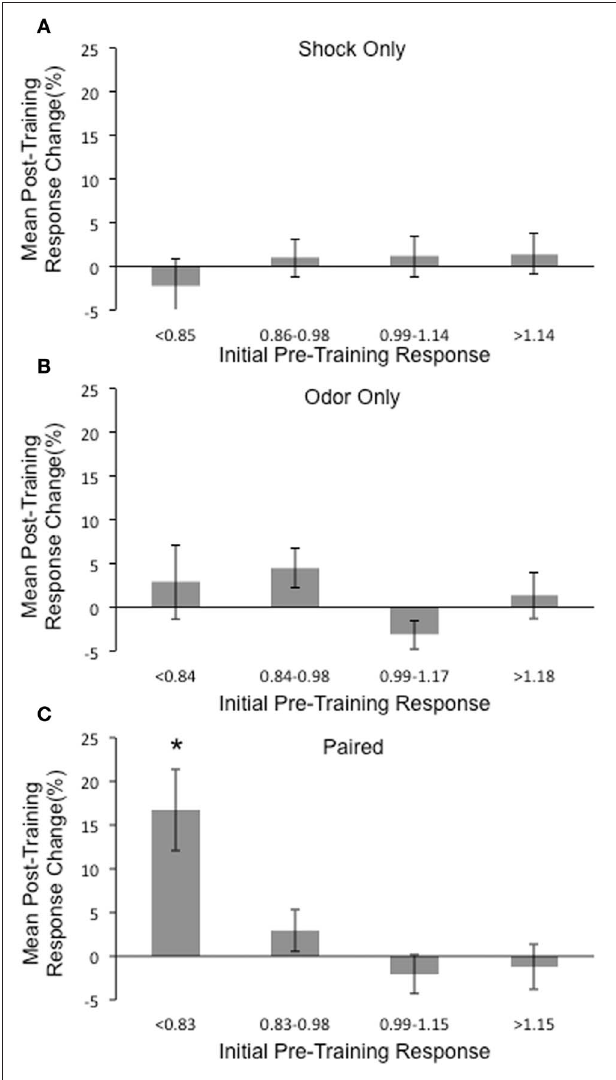
FIGURE 7 | Comparison of the mean post-training response changes in glomeruli based on initial responses to MV. All glomeruli from each group ( n = 327) were divided into quartiles based on their initial normalized responses to MV and the average post-training percent change was calculated for each quartile. (A) No significant mean post-training changes were observed in any quartile for the Shock only group. (B) No significant mean post-training changes were observed in any quartile for the Odor only group. (C) A significant increase in the post-training percent change in glomeruli from the lowest quartile of initial response in glomeruli from the Paired group was found. *Denotes a significant difference between the groups ( p < 0 .